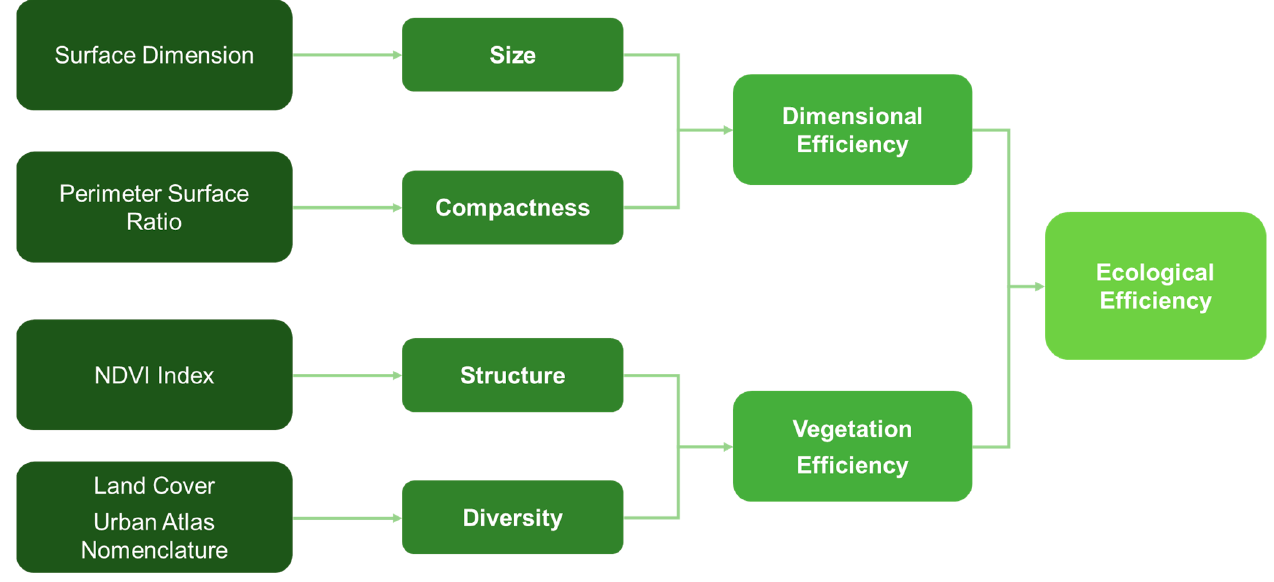
Figure 1. GIS framework model of the ecological efficiency of urban green areas.